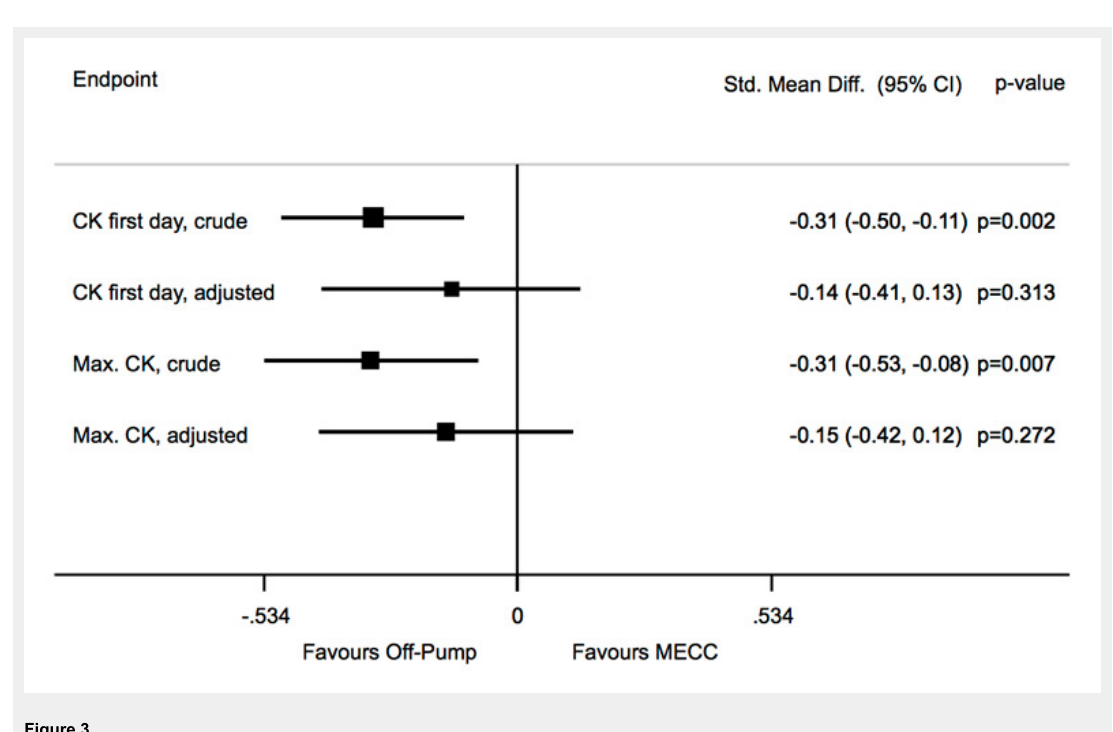
Figure 3 Forest plot regarding the values of CK on the first postoperative day and the peak value of